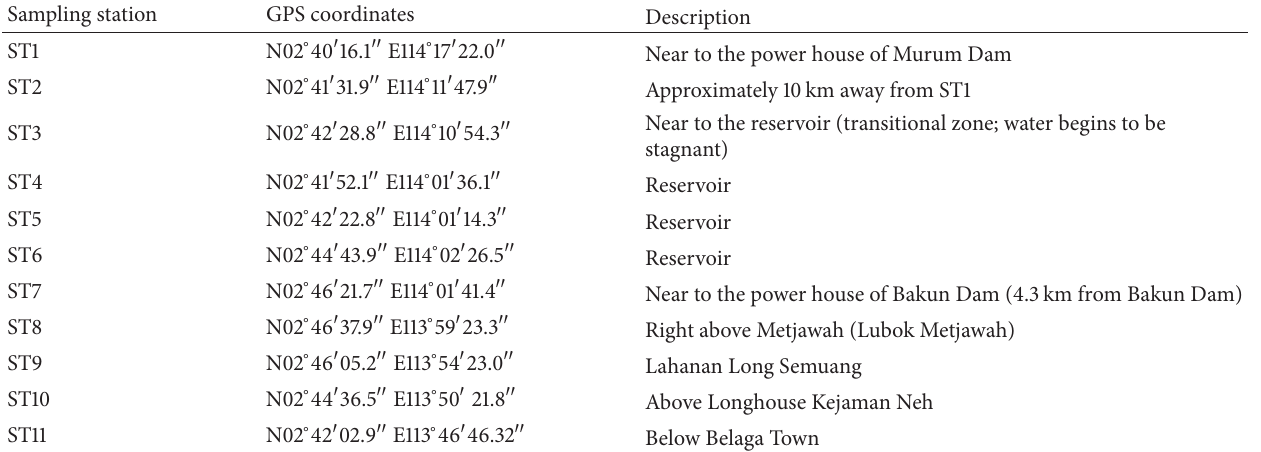
Table 1: The corresponding GPS coordinates of respective stations.